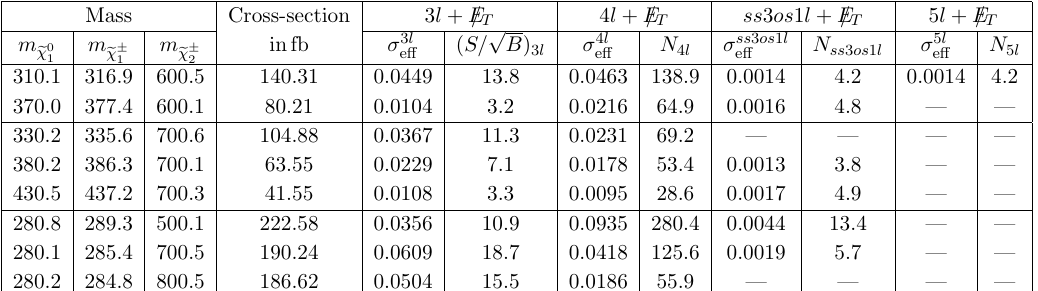
Figure 4 . Exclusion contour in the m line represents exclusion obtained by us using the ATLAS 3 l + E= T search data from Run II. Colors and conventions are same as in (cid:12)gure 1.